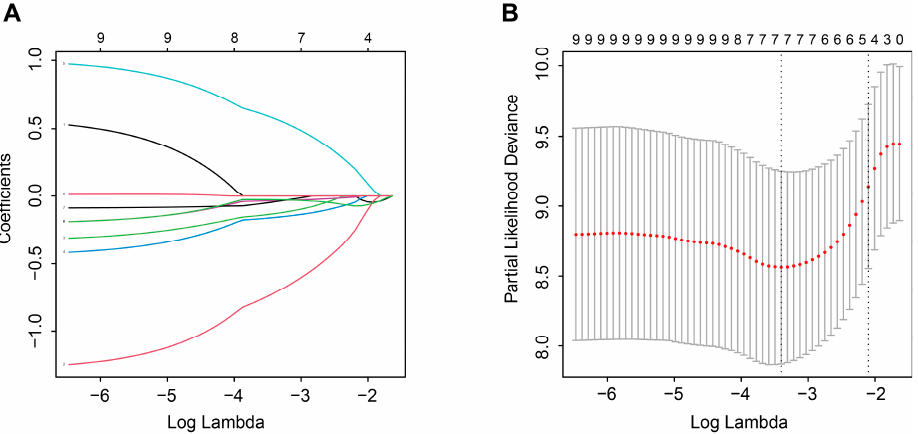
Figure 17. Screening prognostic genes by LASSO regression model. ( A ) Regression coefficient maps of 9 genes under different λ . ( B ) 10-fold cross-validation to determine λ .